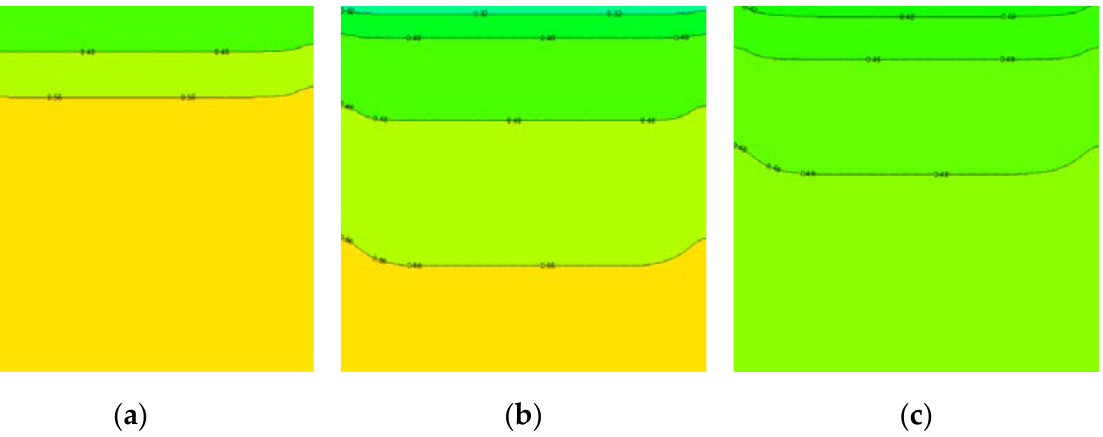
( c ) Figure 12. Remaining oil distribution of each layer after subsequent water flooding stage of Figure 2: ( a ) low-permeability layer, ( b ) medium-permeability layer, ( c ) high-permeability layer . Table 7. The remaining oil saturation (%) results of Figure 2 . Well Pattern Types Injection Stage Horizontal Well Pattern ( Figure 2 ) Low-Permeability Layer